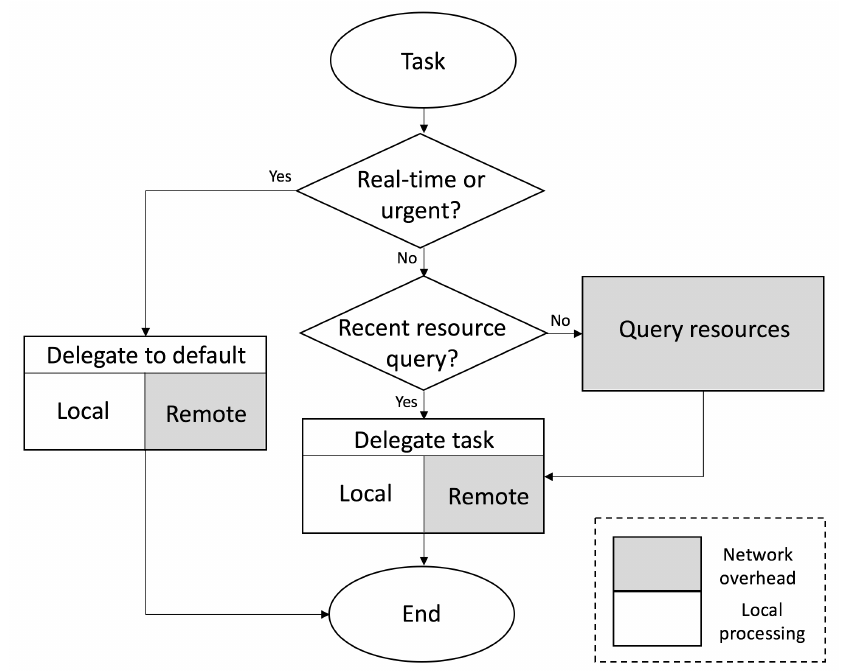
Figure 2. Design of CAMEVAN task